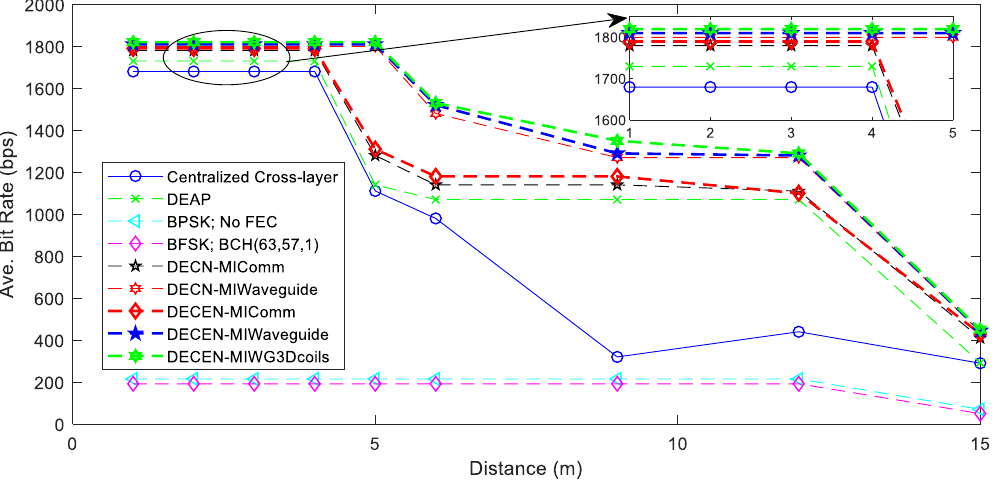
Figure 8. Comparison graph for average bit rate as a function of distance.